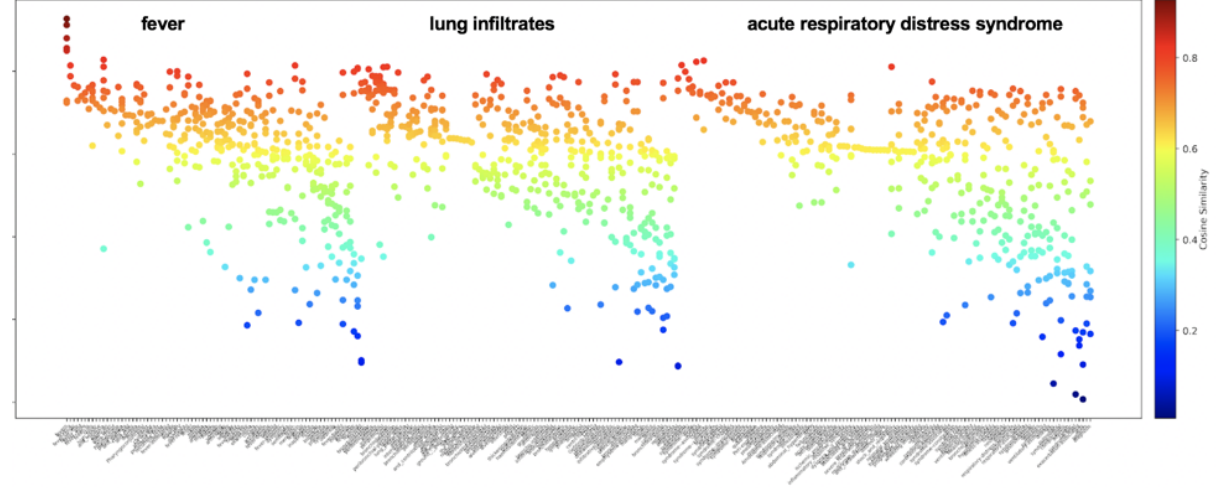
Figure 8. Cosine similarity measures for each unique returned term among the top 20 terms across all word embedding sources returned for the queried terms “fever,” “lung infiltrates,” and “acute respiratory distress syndrome.” Color range indicative of cosine similarity level (0.0-1.0), not semantic